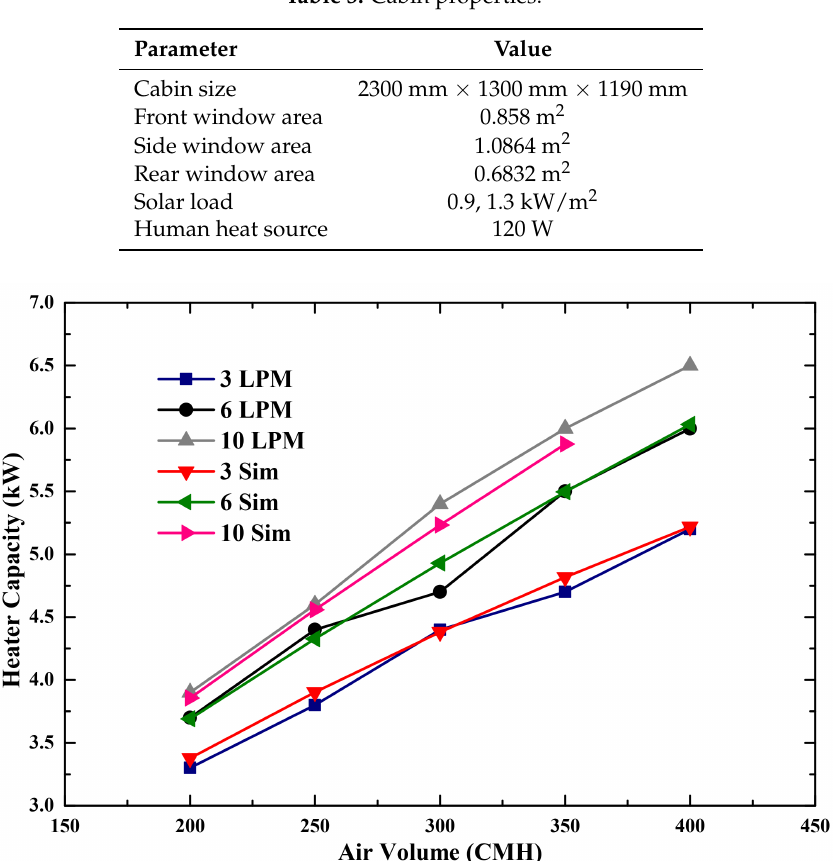
Figure 7. Heater core capacity with air